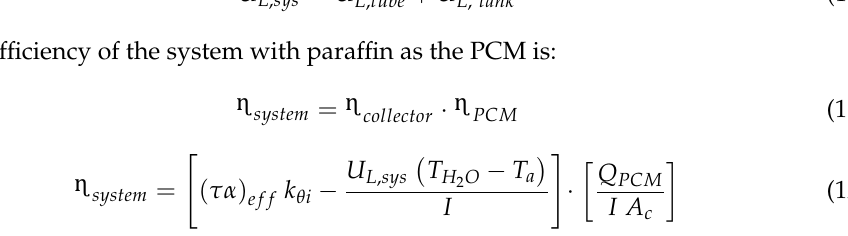
Figure 3. Hydronic evacuated tube solar system with a PCM: ( a ) photographic view; ( b ) schematic diagram.